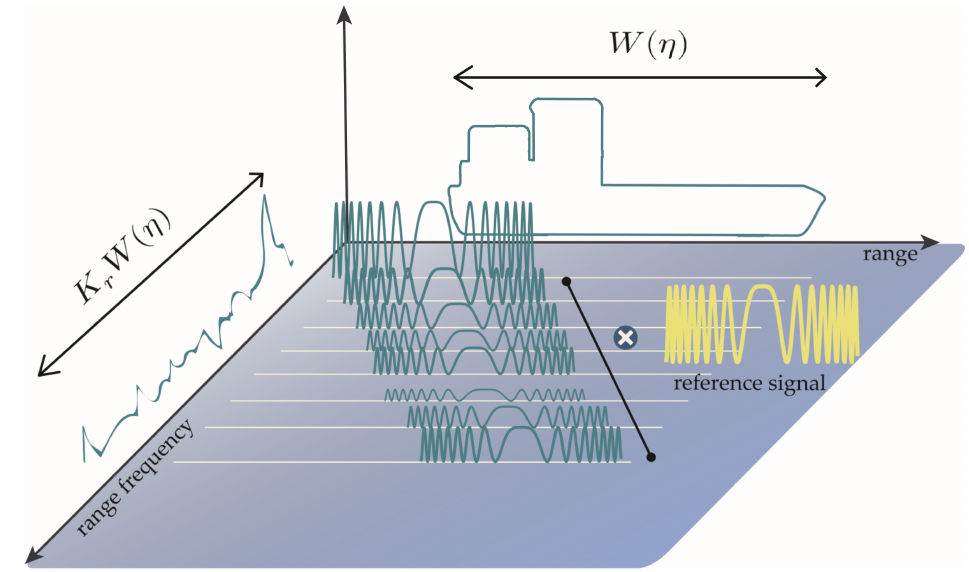
Figure 7. Dechirping receiving for a distributed ship